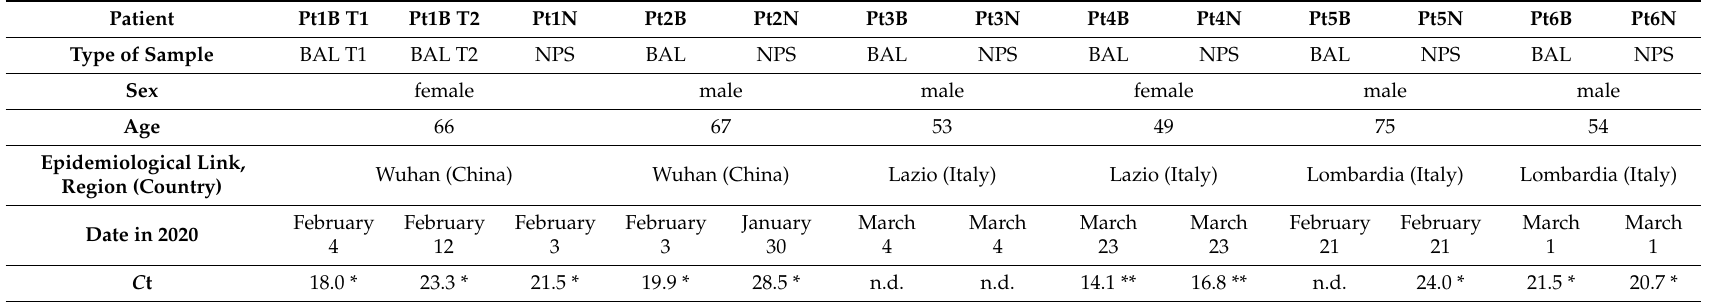
Table 1. Demographic, epidemiological, and virological data for the collected